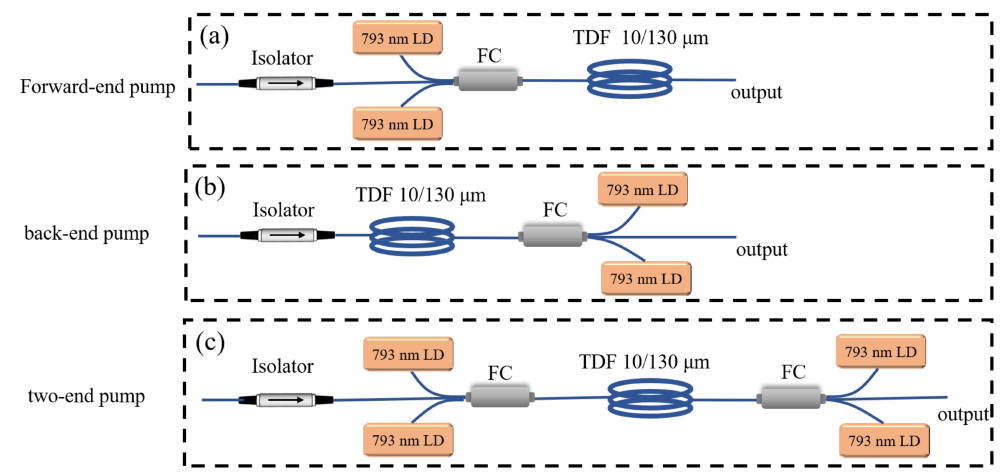
Figure 3. Schematic diagram of ( a ) forward-end pump, ( b ) back-end pump, and ( c ) two-end pump.